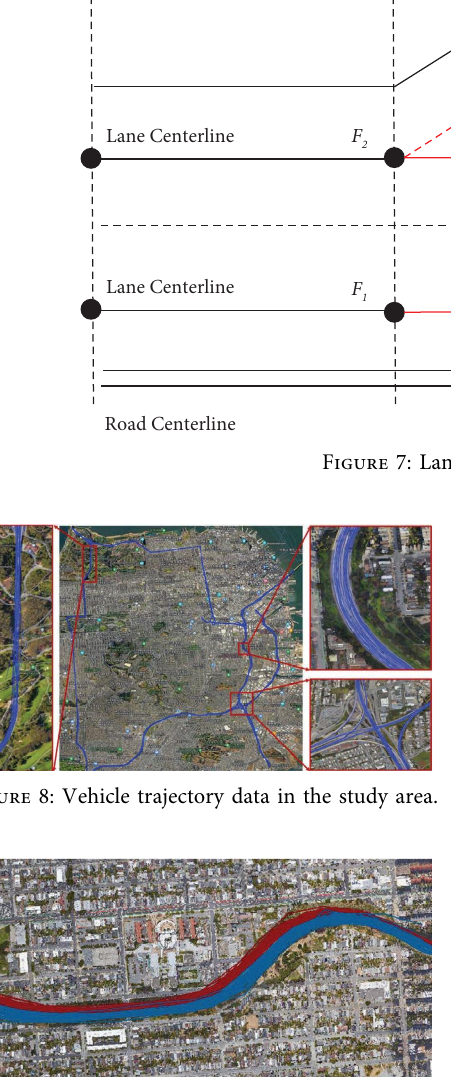
Figure 9: Preprocessed vehicle trajectory data. Table 1: Parameters setting of the proposed method. Parameter Value Max number of the lanes 6 Length interval of road cross sections 20 meters